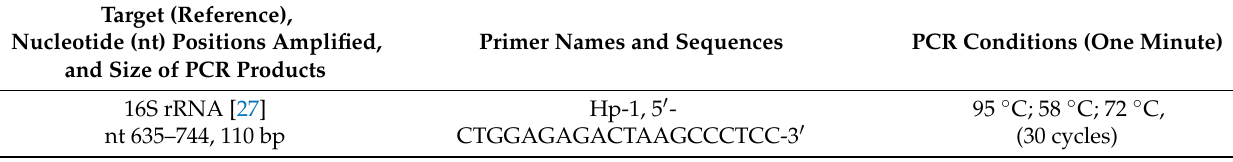
Table 9. Oligonucleotide sequences used in this